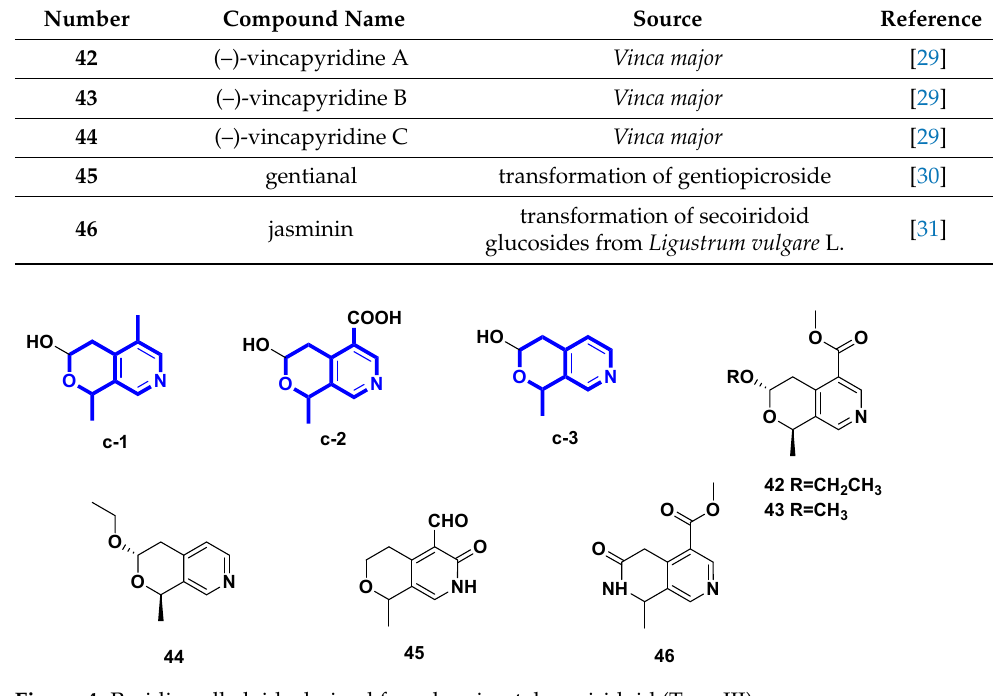
Figure 5. Structures of pyridine alkaloids derived from secoiridoids (Type IV).